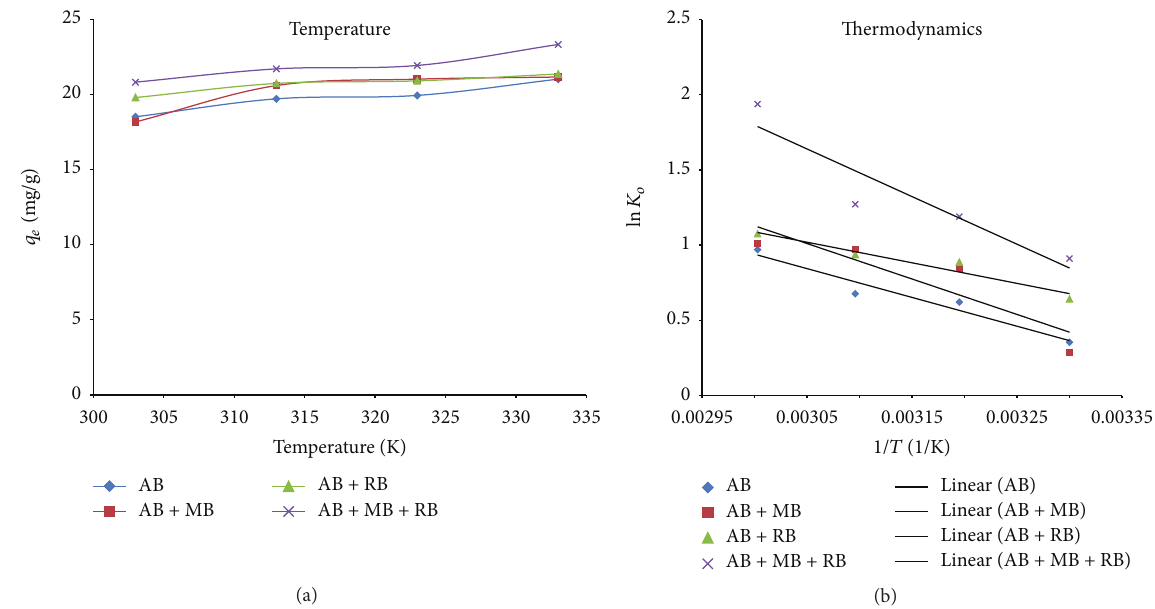
Figure 9: Effects of temperature (a) and thermodynamics (b) of adsorption of Acid Blue 161 on